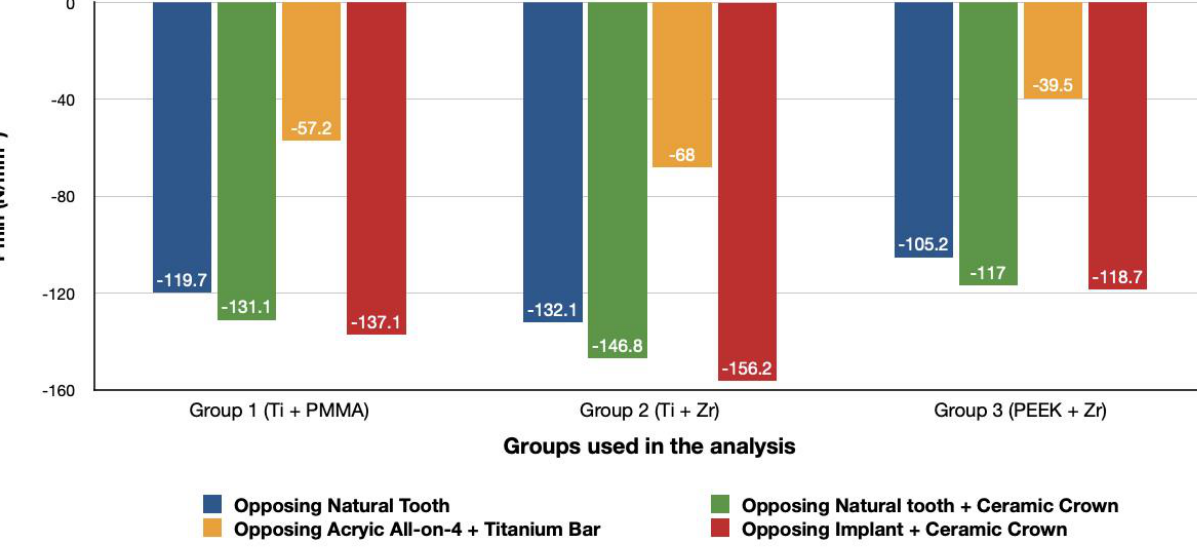
Figure 8. Minimum principal stresses (N/mm 2 ) on cortical bone.